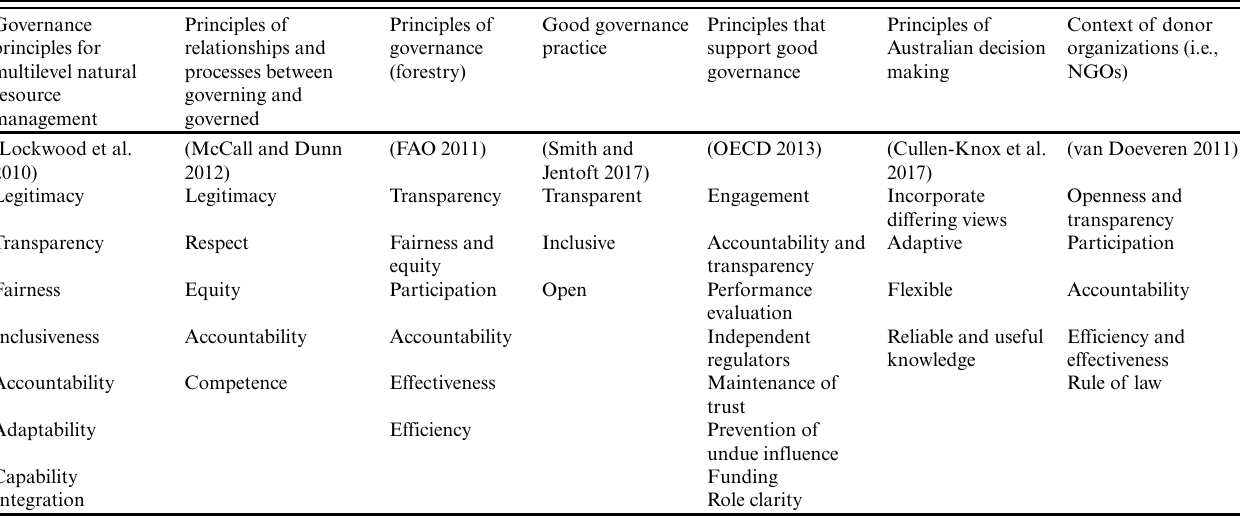
Table 1 . Good governance principles as listed in selected peer reviewed papers and reports (principles listed in no particular order and original wording has been maintained as far as practical).